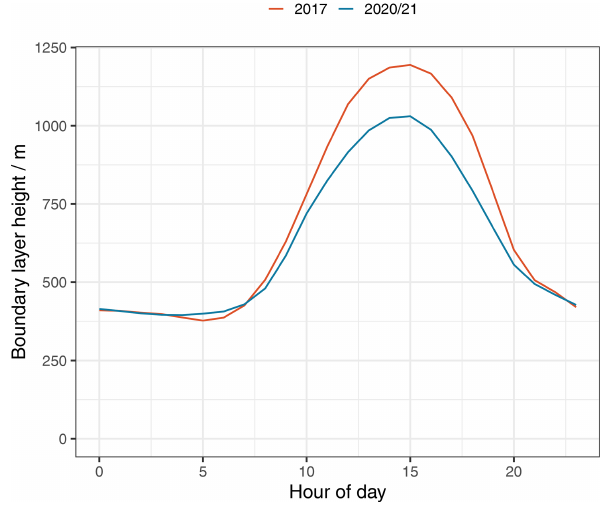
Figure A5. Boundary layer height comparison.